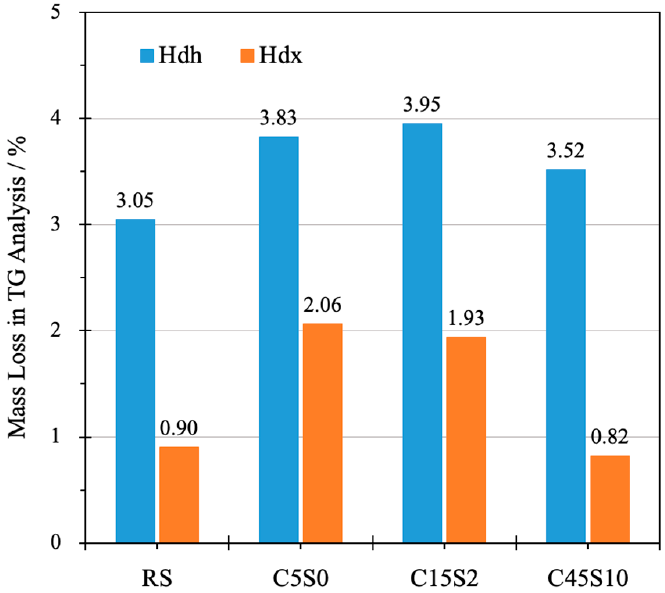
Figure 13. Dehydration and dihydroxylation values in TG analysis.